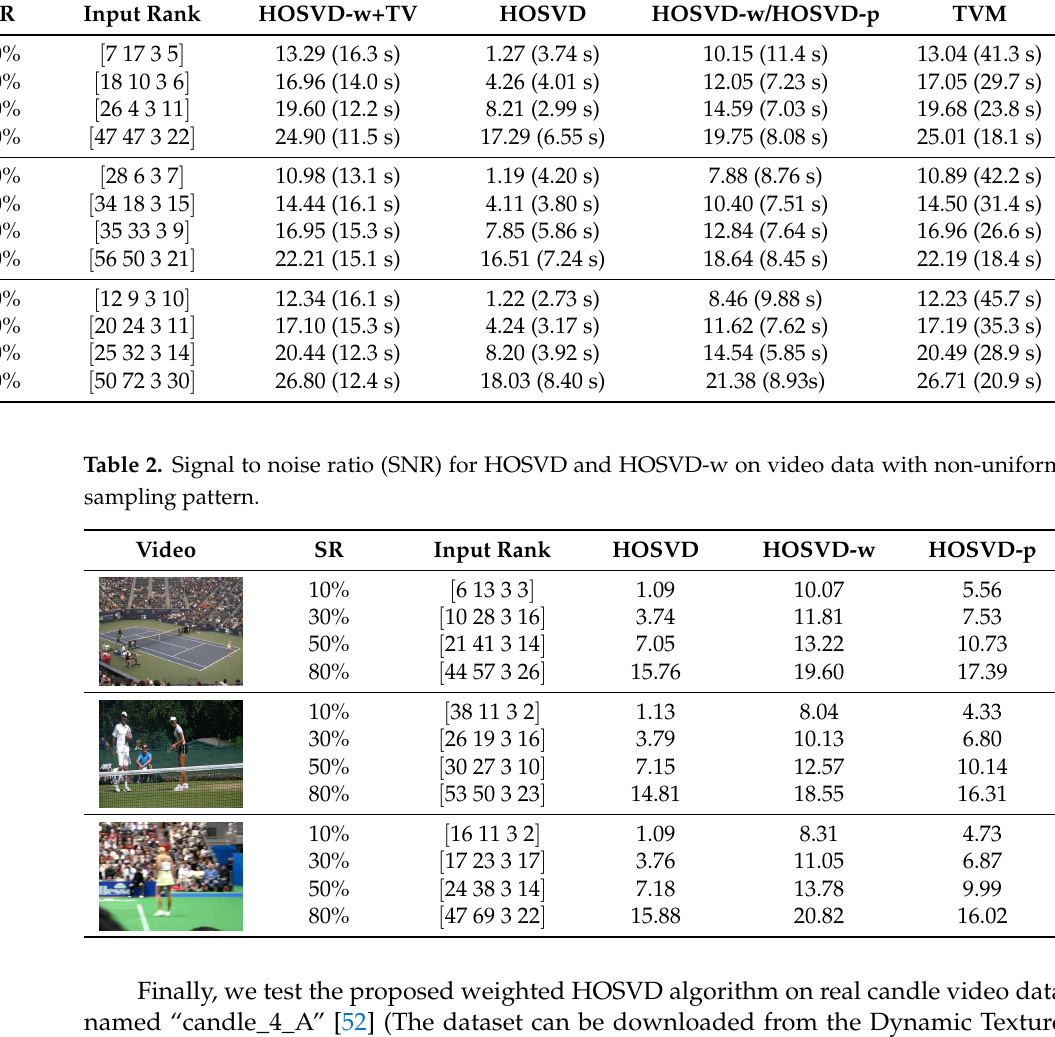
Table 1. Signal to noise ratio (SNR) and elapsed time (in second) for Higher Order Singular Value Decomposition (HOSVD) and HOSVD-w on video data with uniform sampling pattern. The HOSVD-w and HOSVD-p behave very similar for uniform sampling hence we integrate the results into one column. Video